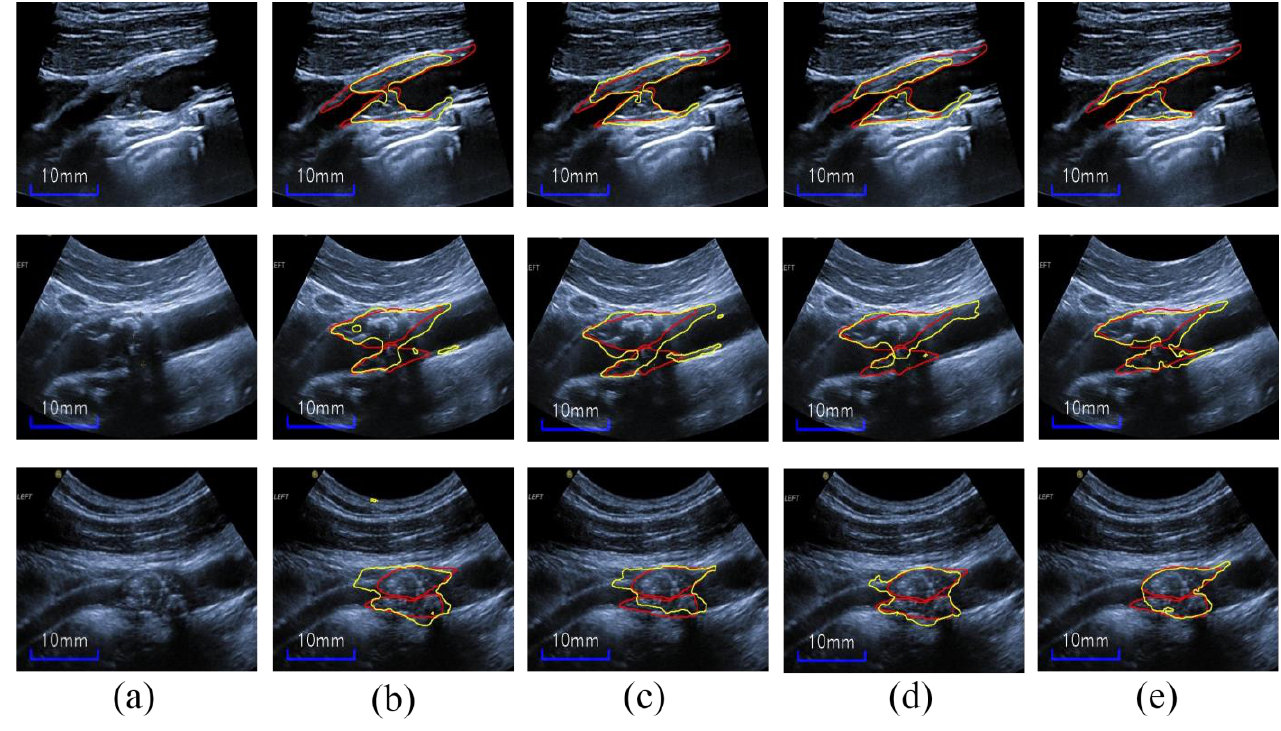
16 of 24 Figure 11. CBV effects on Dice metric ( a ) and MHD metric ( b ) of the seven cutting-edge methods.